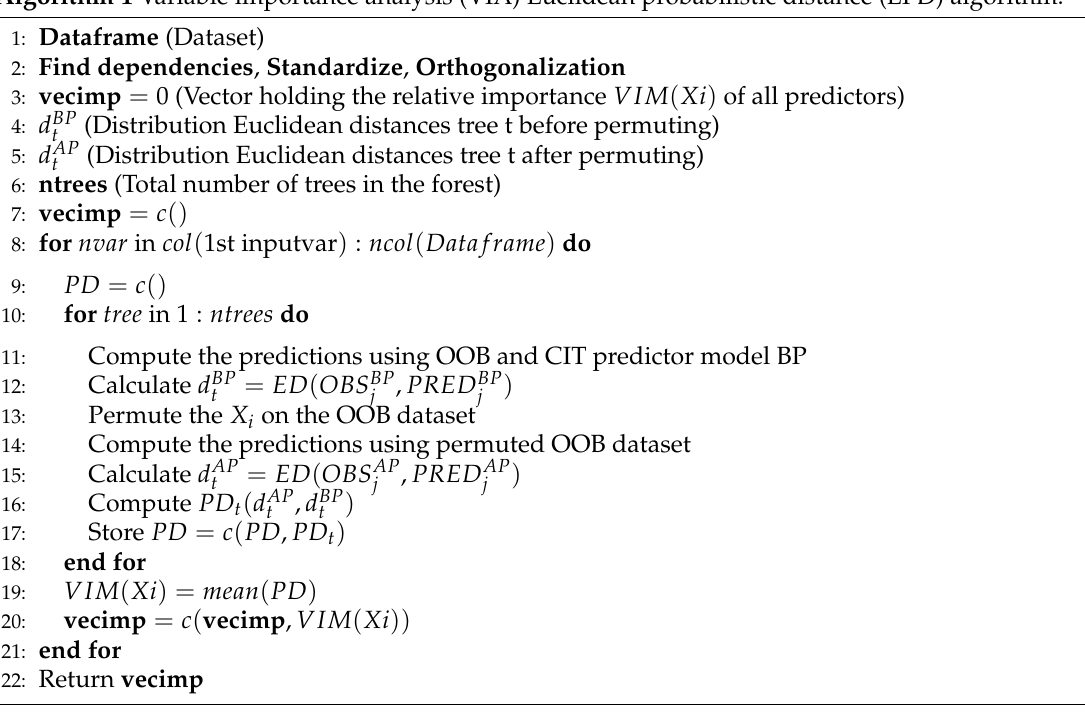
Algorithm 1 Variable importance analysis (VIA) Euclidean probabilistic distance (EPD)